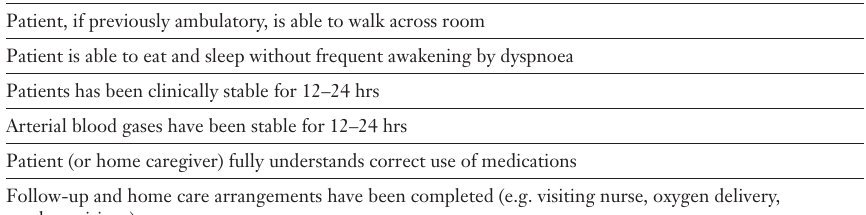
Discharge criteria for patients with acute exacerbations of